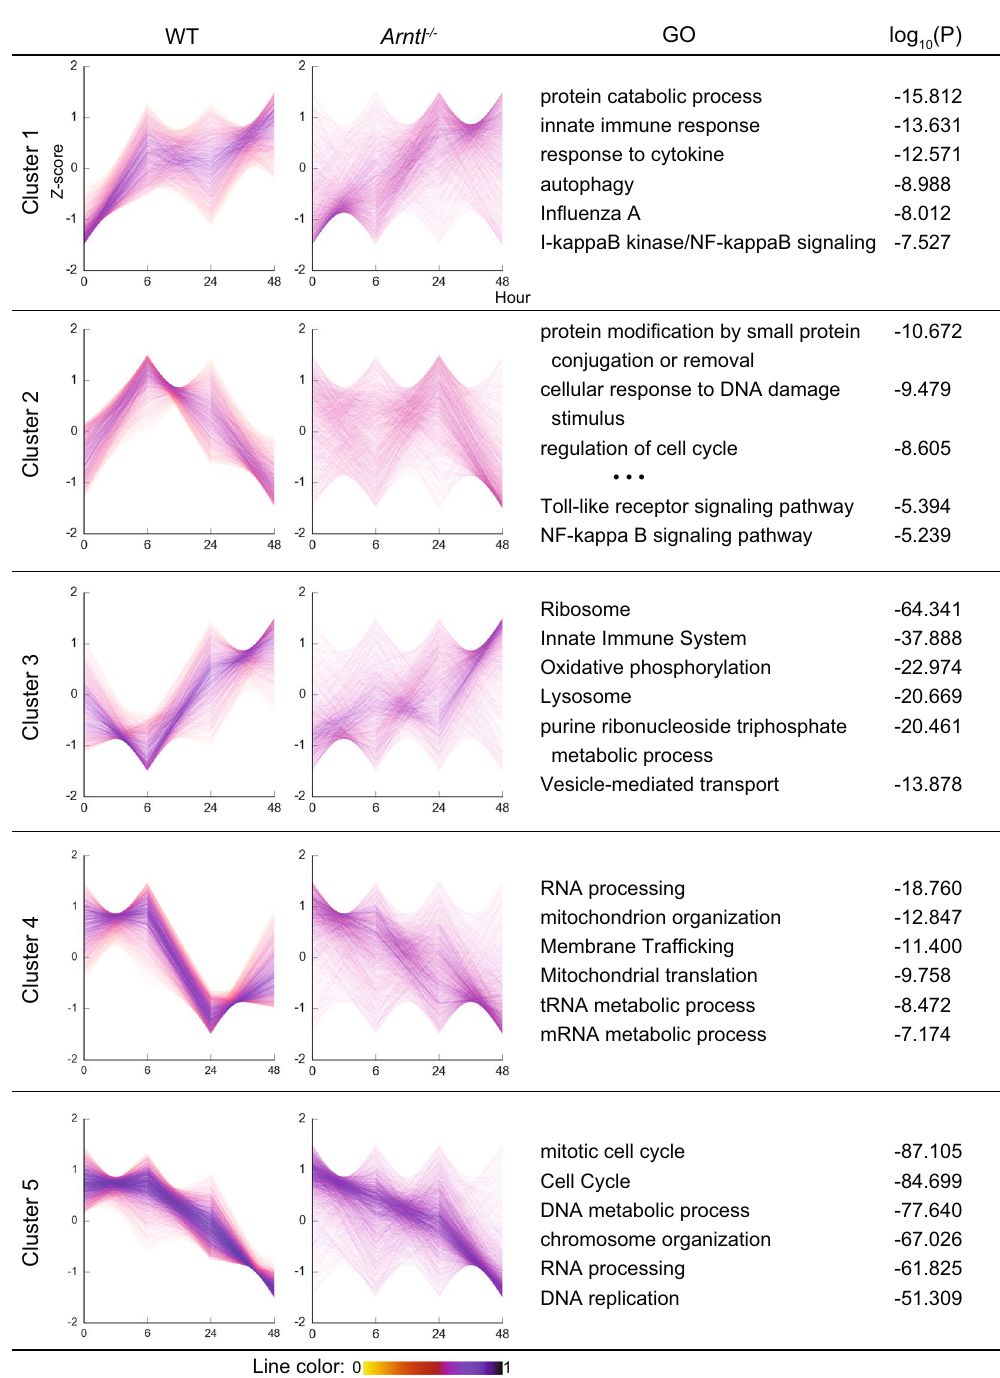
Figure 1. Clustering and time-course expression of genes after TLR4 activation. Bone marrow-derived macrophages prepared from WT and Arntl − / − mice were treated with KLA for 0, 6, 24 or 48 h, after which their transcriptomes were analyzed using RNA-seq. RefSeq genes with normalized counts ≥ 100 at one or more time point in WT macrophages were clustered into 5 groups using the Mfuzz clustering method 20 . Prior to Mfuzz clustering, normalized counts were standardized so that the average counts for each gene was zero and the standard deviation was one. The genes with membership scores ≥ 0.3 were chosen as the members of each cluster in the following analyses. Expression levels of each gene (Z-score) are shown as line graphs. The color gradient of lines from purple to pink indicates the membership score. Normalized counts of each gene in Arntl − / − cells were also standardized and shown as line graphs. GO terms associated with each cluster are